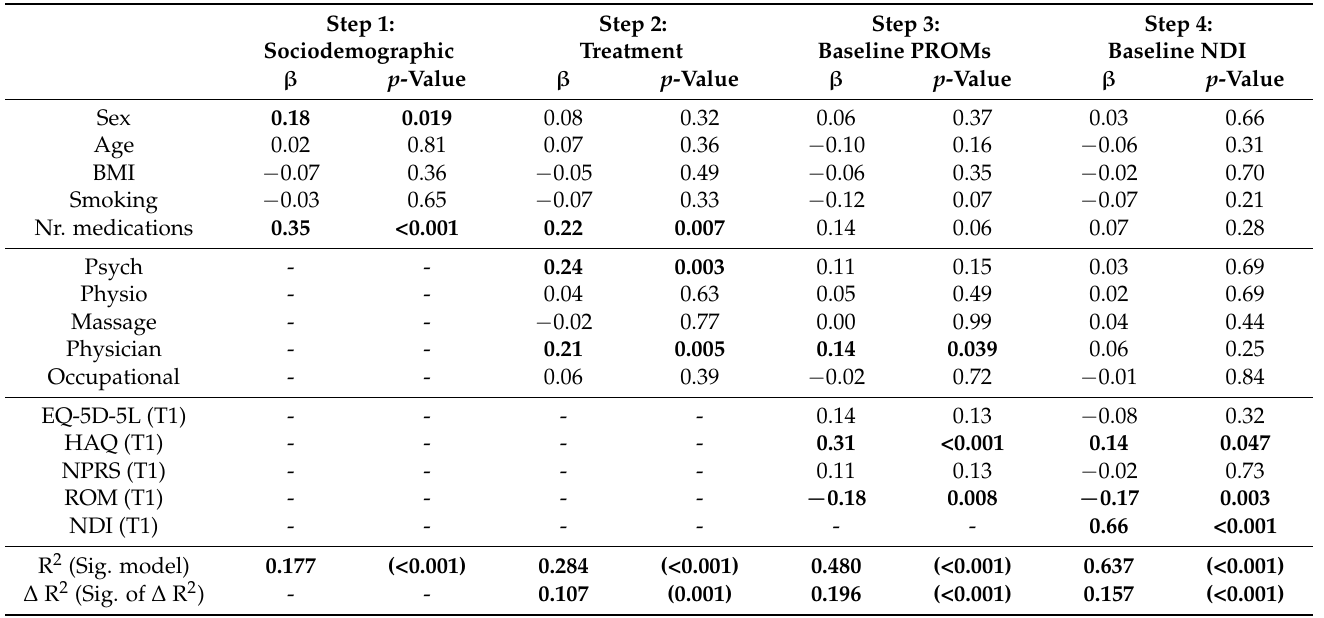
Table 6. Hierarchical multiple linear regression model for variables associated with NDI scores at the end of treatment ( T